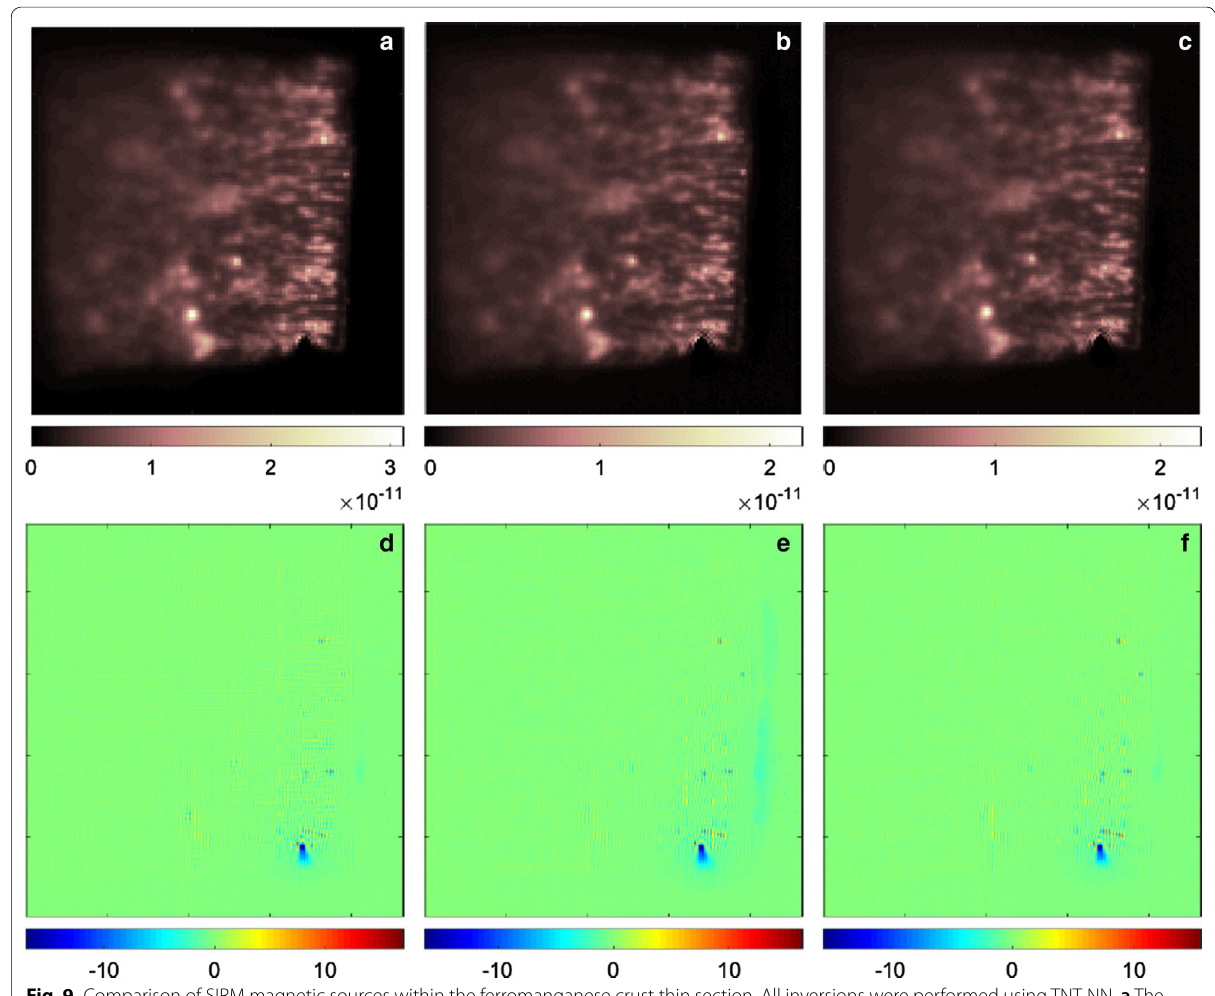
Fig. 9 Comparison of SIRM magnetic sources within the ferromanganese crust thin section. All inversions were performed using TNT-NN. a The SIRM magnetic moments found using a dipole spacing of 200 µ m, and cropped to a 23.1 mm × 24.1 mm field of view, b the SIRM magnetic moments found using a 23.1 mm × 24.1 mm cropped view and a magnetic source resolution of half the sensor-to-sample distance (160 µ m dipole spacing), c the SIRM magnetic moments found using the full 30.1 mm × 32.1 mm view and a magnetic source resolution of half the sensor-to-sample distance (160 µ m dipole spacing) shown using the same 23.1 mm × 24.1 mm field of view as a and b , d solution residuals of a , e